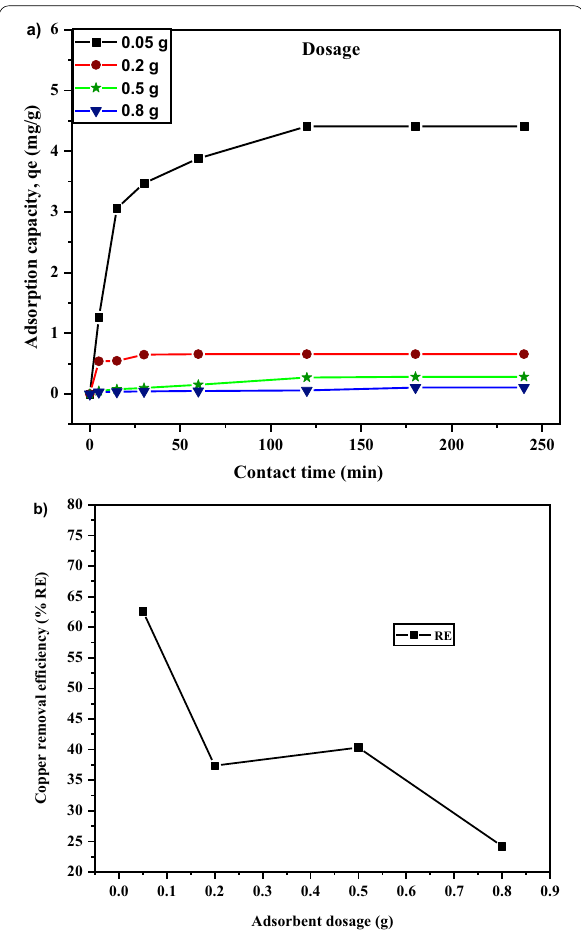
Fig. 12 a Adsorption capacity; b Copper removal efficiency